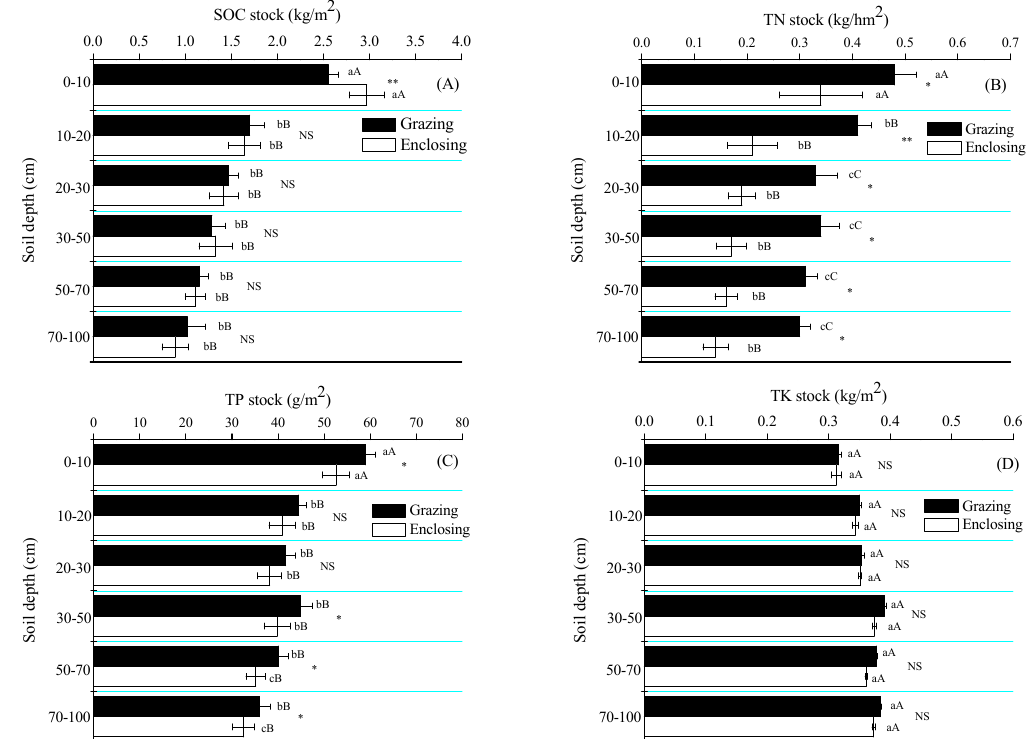
Figure 5. The SOC ( A ), TN( B ), TP ( C ), and TK ( D ) stocks of treatments. Note: * and ** show significant differences at p < 0.05 and p < 0.01 of SOC, TN, TP, and TK stocks in each soil layer between two treatments, and NS shows no difference ( t -test). Lowercase and capital letters show significant differences at p < 0.05 and p < 0.01 of SOC, TN, TP, and TK stocks among different soil layers in each treatment by ANOVA. Error bars are one standard deviation.